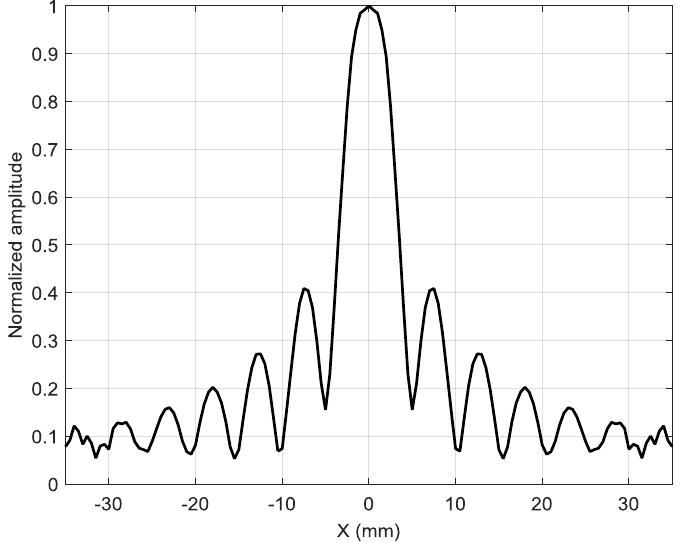
Figure 14. Calculated spatial distribution of the normalized displacement amplitudes in the plastic film along the x axis at y = 0 excited by a single rectangular element.